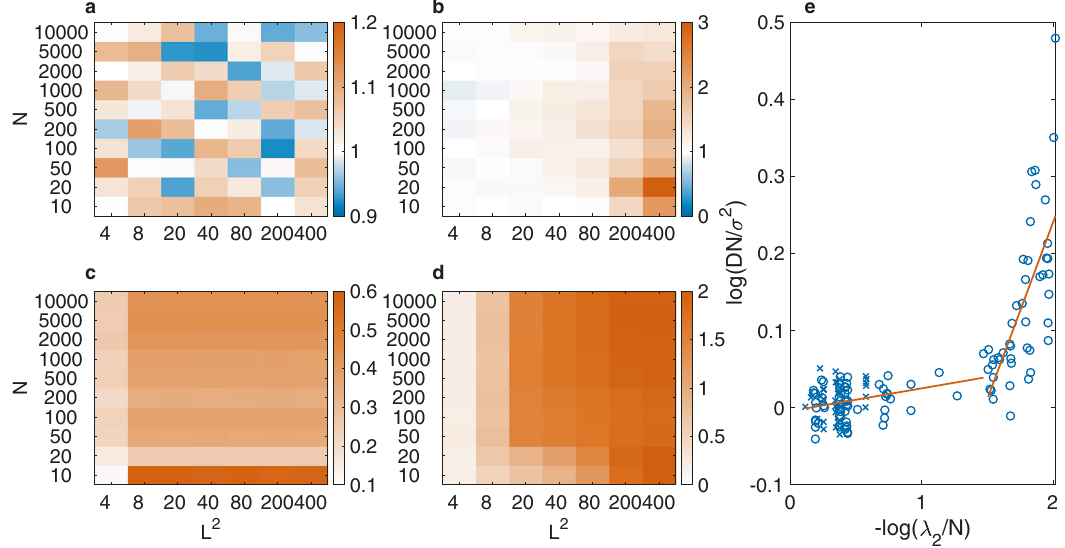
Fig. 2 Computational validation of the proposed inference approach. a , b Color maps of DN / σ 2 , where D is the diffusion coef fi cient and σ 2 is the noise variance, as a function of the side length L of the square domain and the system size N for η = 0.1 ( a , b correspond to speed s = 0.3 and s = 3, respectively, see Supplementary Note 5 for details on the speed selection). Perfect inference of the size of the collective ( DN / σ 2 = 1) is indicated in white, the darker the red the worse is the underestimation ( DN / σ 2 > 1), and the darker the blue the worse is the overestimation ( DN / σ 2 < 1). c , d Color maps of (cid:2) log ð λ 2 = N Þ as a function of the side length L of the square domain and the system size N for η = 0.1 ( c and d correspond to s = 0.3 and s = 3, respectively). Higher values (cid:2)(cid:2) (cid:3) of (cid:2) log ð λ 2 = N Þ correspond to a lower average connectivity of the system. e Scatter plot of the pairs (cid:2) log λ 2 = N ; log ð DN = σ 2 Þ , with crosses and circles corresponding to s = 0.3 and s = 3, respectively. The red lines correspond to the linear fi t of the pairs with (cid:2) log ð λ 2 = N Þ lower than 1.50 ( R 2 = 0.08) and larger than 1.50 ( R 2 = 0.49), respectively.